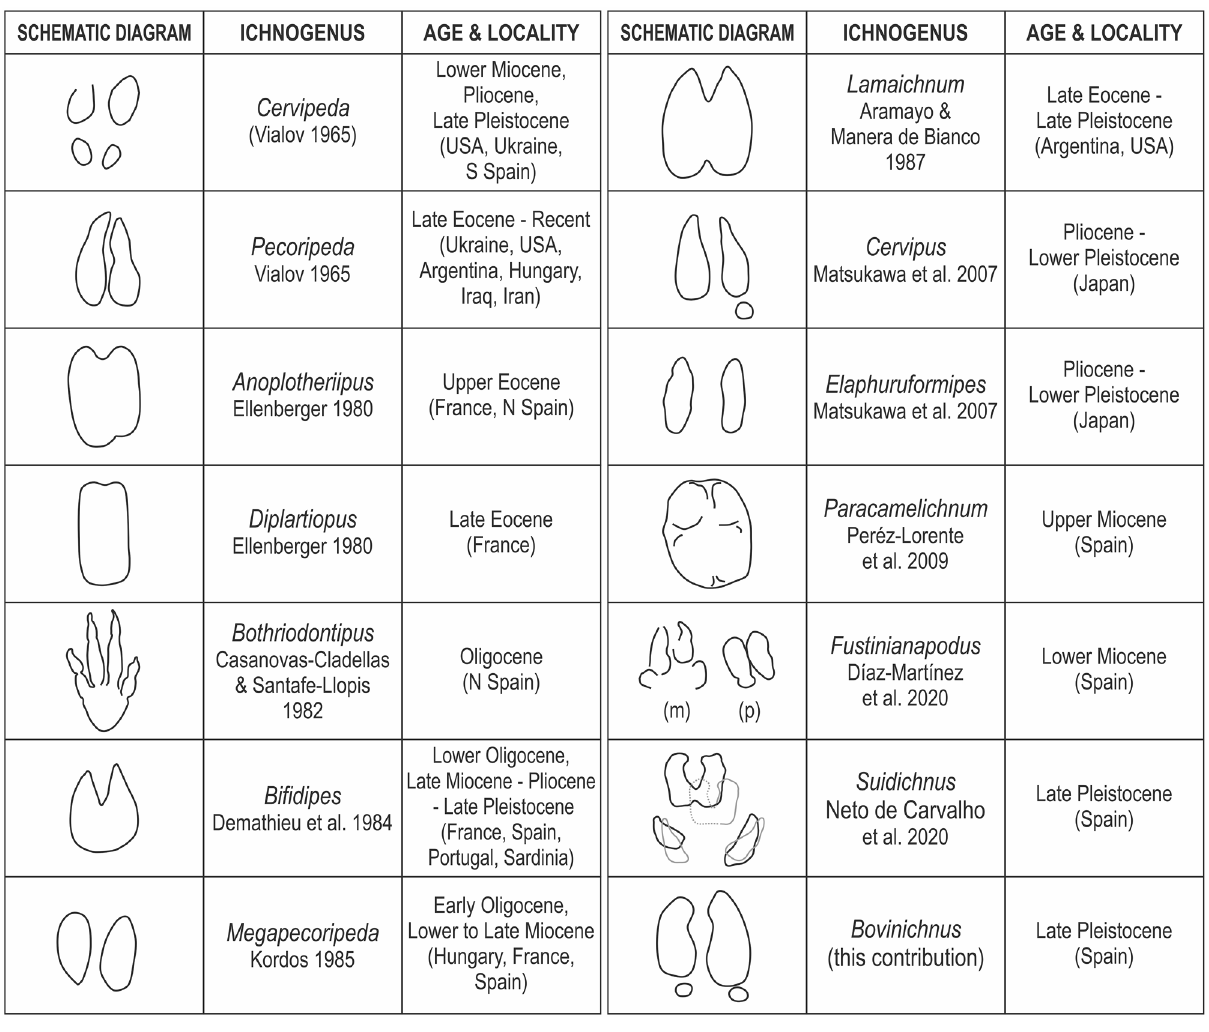
Figure 7. Revision of the valid artiodactyl ichnogenera 16 with visual comparison of morphologies, age and locality (country). All tracks have been redrawn from the original references where they were described for the first time. (m) manus , (p) pes. Anoplotheriipus left pes ; Diplartiopus left pes ; Bothriodontipus pes (not indicated which side); Lamaichnum manus (not indicated which side); Paracamelichnum right manus ; Fustinianapodus left manus and pes ; Suidichnus overprinting of left manus by corresponding pes ; Bovinichnus right track; for other ichnogenera autopods were not specified/shown no morphological distinction in the references. This figure has been drawn with CorelDraw X6 (https:// www. corel draw. com/